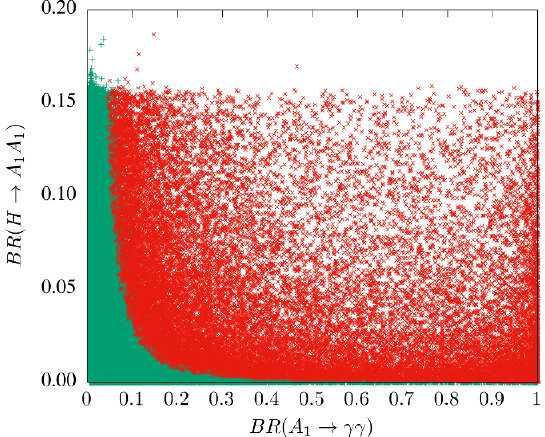
Figure 2 . Allowed range of BR (H 1 ! A 1 A 1 ) and BR (A 1 ! (cid:13)(cid:13) ). Red (Green) region is excluded (allowed) by the limit on (cid:12) ,